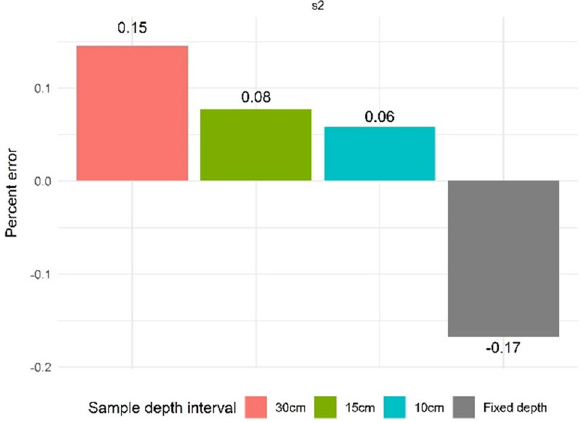
Figure 6. Correction errors (%) at time point t2 for sample depth intervals 10 cm, 15 cm, and 30 cm (scenarios 2a, 2b, and 2c, respectively) compared to the scenario 2 fixed depth